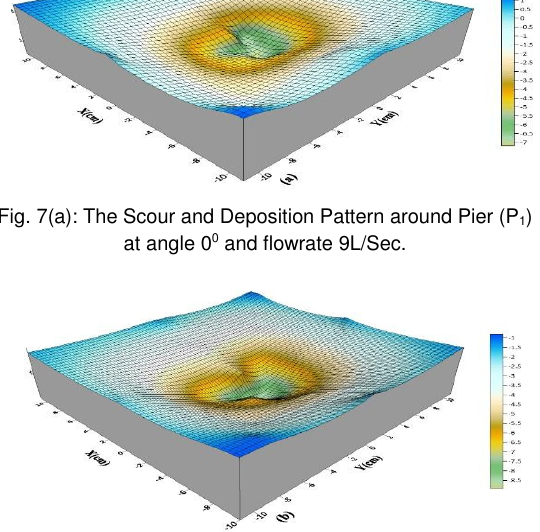
Fig. 7(b): The Scour and Deposition Pattern around Pier (P 1 ) at angle 0 0 and flowrate 14L/Sec.